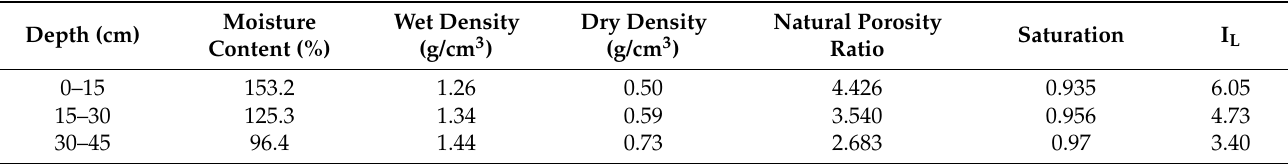
Table 3. Physical properties of the seafloor soil.